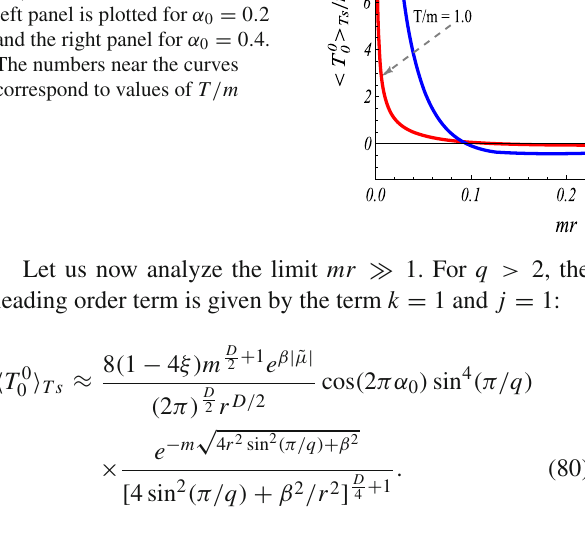
(cid:3) Fig. 3 The (cid:2) T 0 Ts part is 0 plotted for D = 3 as a function of the product mr , with fixed parameters q = 3 . 5, | ˜ μ | / m = 0 . 5 and ξ = 0. The left panel is plotted for α 0 = 0 . 2 and the right panel for α 0 = 0 . 4.